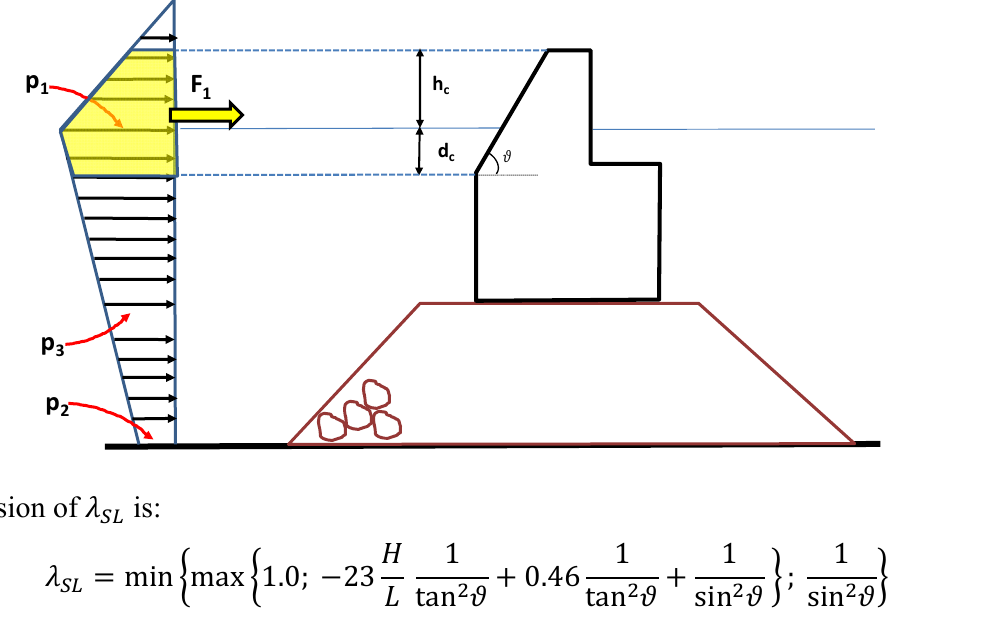
Figure 9. Definition sketch for the method of Morihira and Kunita.